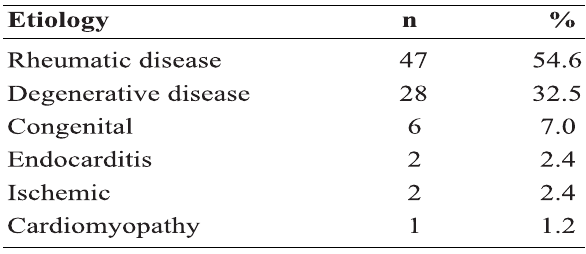
Table 2. Mitral insufficiency